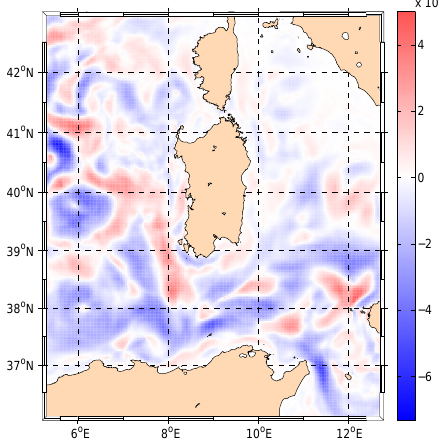
Figure 11. Wind stress work difference (BFC – BF). Units are Wm − 2 . Blue negative patches indicate where the wind power in- put is reduced by the feedback of currents on momentum